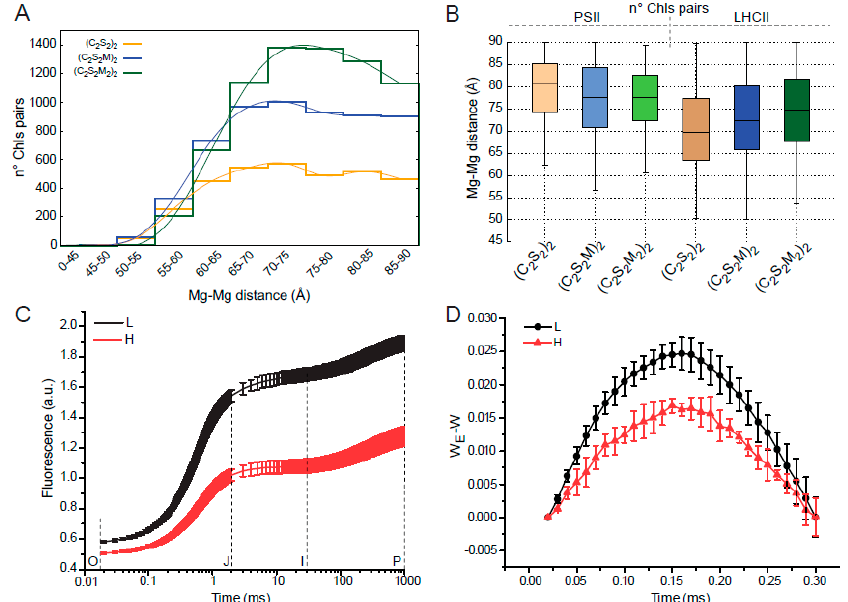
Figure 5. Distance distribution of stromal chlorophylls pairs and PSII excitonic connectivity in paired PSII-LHCII supercomplexes with different antenna size. ( A ) Distribution of Mg-Mg distances calculated for Chls pairs made by a stromal Chl of the upper supercomplex and a stromal Chl of the lower supercomplex within a cut-off of 90 Å and ( B ) corresponding box-plot highlighting the contribution of the Chls pairs, belonging exclusively to PSII cores (left) or LHCII antennae (right), in paired PSII-LHCII supercomplexes of different antenna size. ( C ) Chlorophyll a fluorescence induction curves (i.e., the OJIP transient) plotted on a logarithmic time scale for paired PSII-LHCII supercomplexes isolated from H and L samples. ( D ) Estimated PSII energetic connectivity as plot of (W E —W), where W and W E (shown in Figure S5A) correspond respectively to the normalized O–J phase of the experimental OJIP curve and of the theoretical exponential curve corresponding to the unconnected system (for calculation of W and W E , see Figure S5D). Graphs in panels C-D display the mean values ± standard deviations of six replicates.